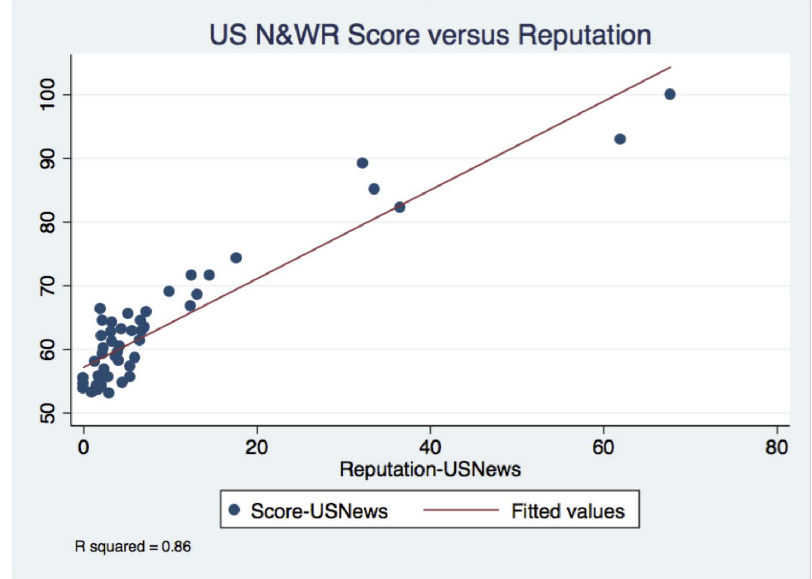
Figure 2. The relationship between US News and World Report Score and Reputation.